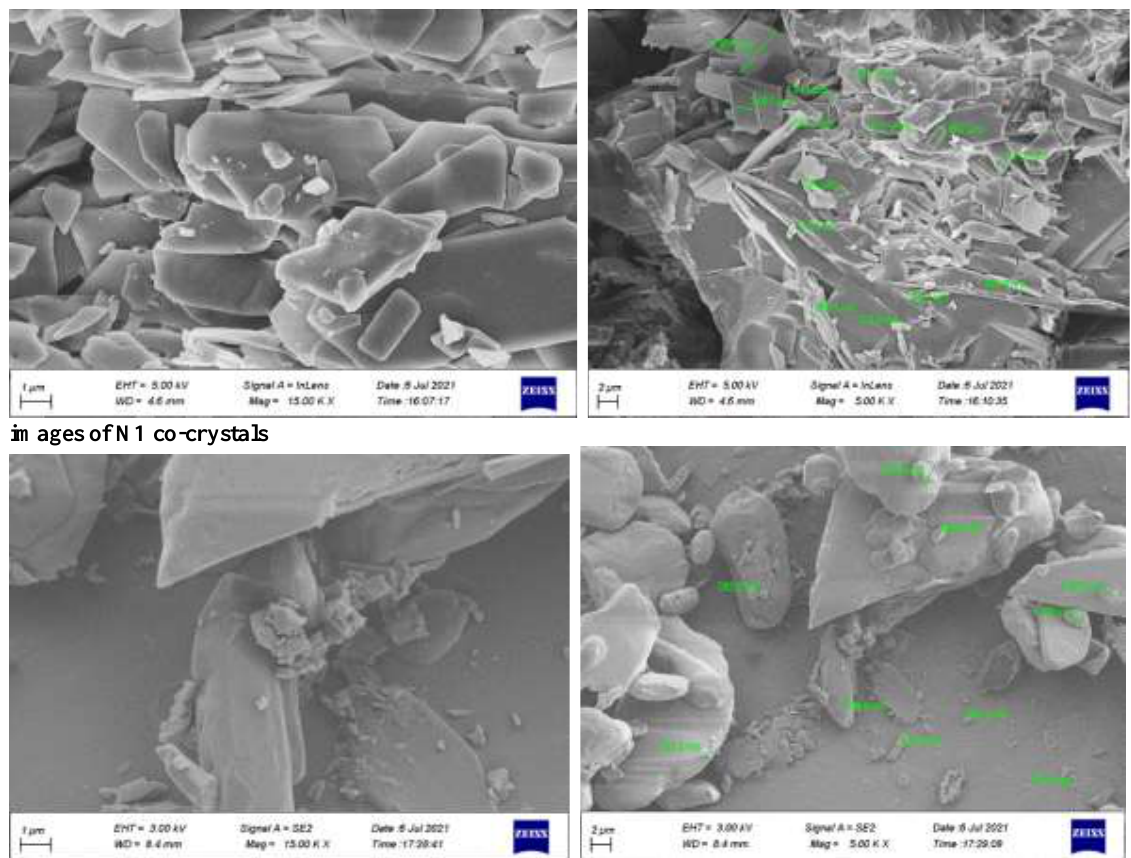
Figure 16. FESEM images of N1 co-crystals (upper row) and FESEM images of C1 physical mixture (lower row).